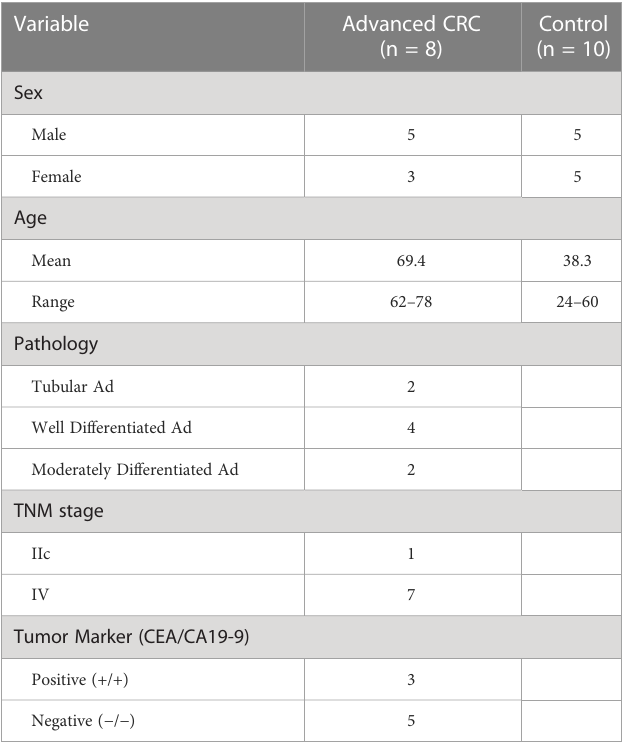
TABLE 1 Clinical characteristics of advanced CRC